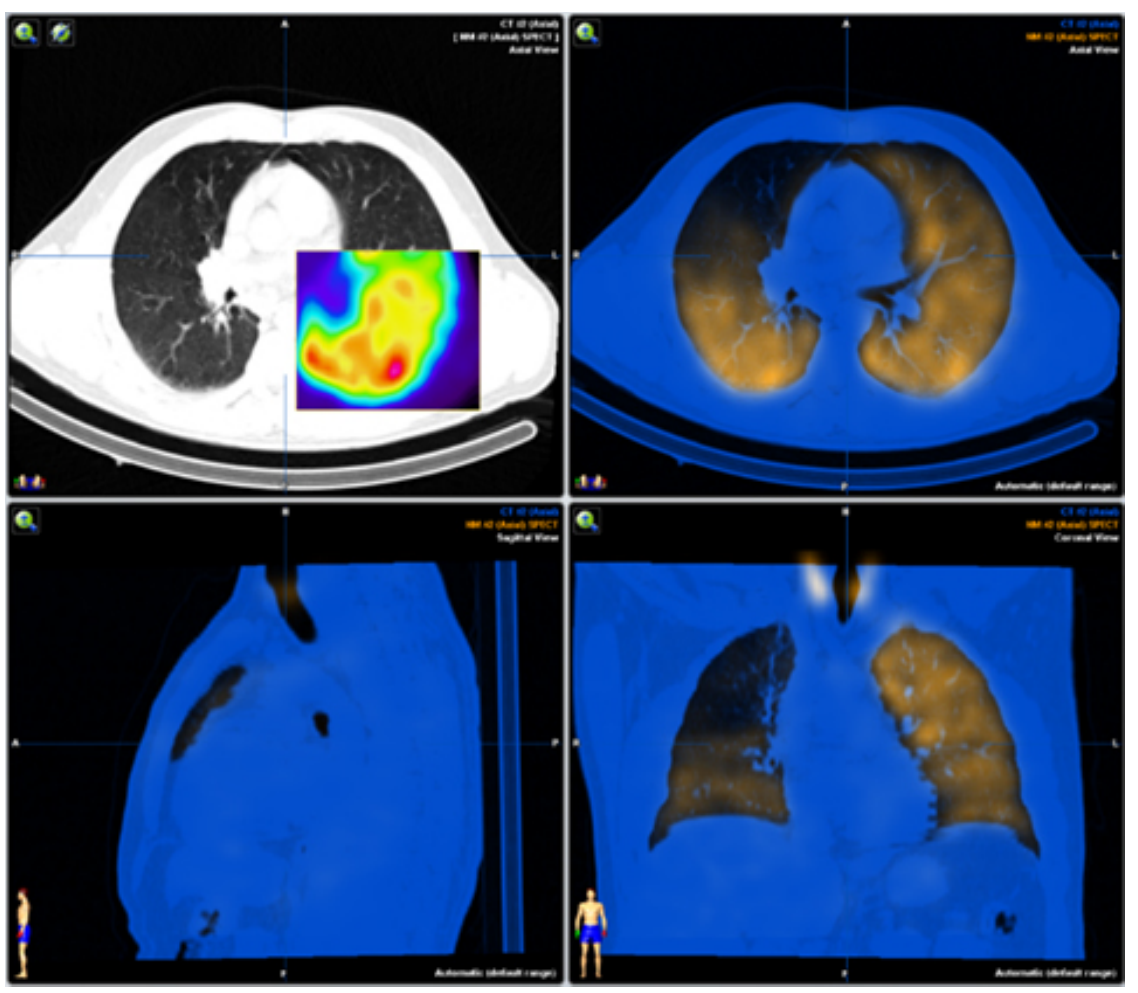
Fig. 1. Radiotherapy planning computed tomography (CT) scans co-registered with SPECT scans.